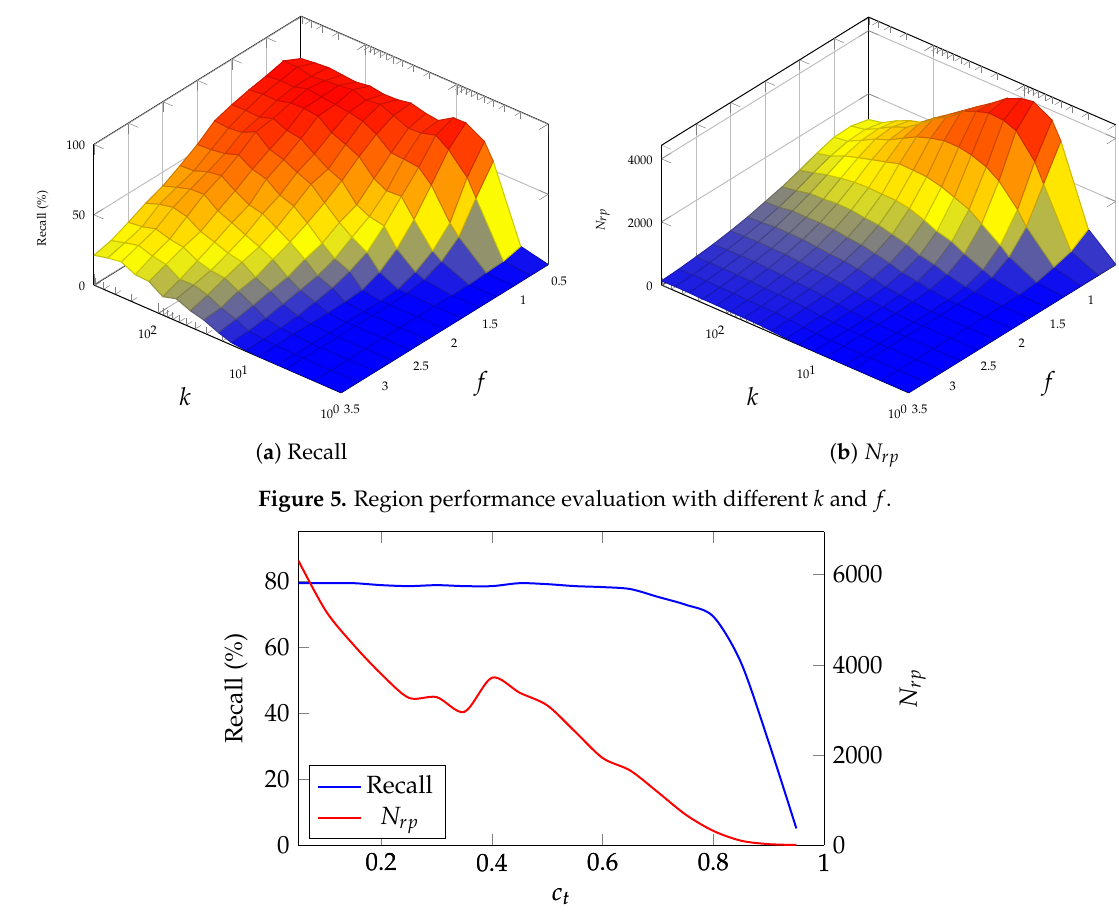
Figure 6. Region proposal performance by different c t with k = 81, f = 1.25.